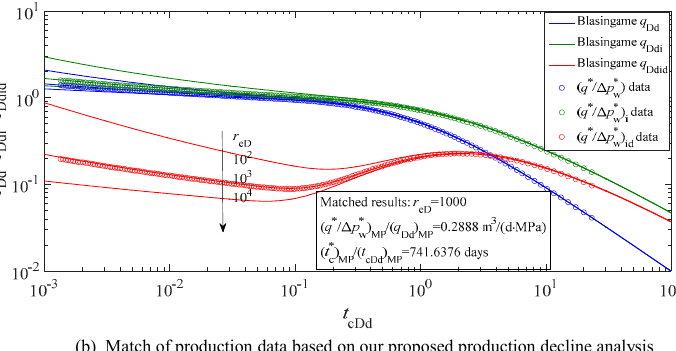
Figure 10. Match of production data for CPP case of Table 4. Comparison between the results obtained by BPDA and PPDA for CPP cases.